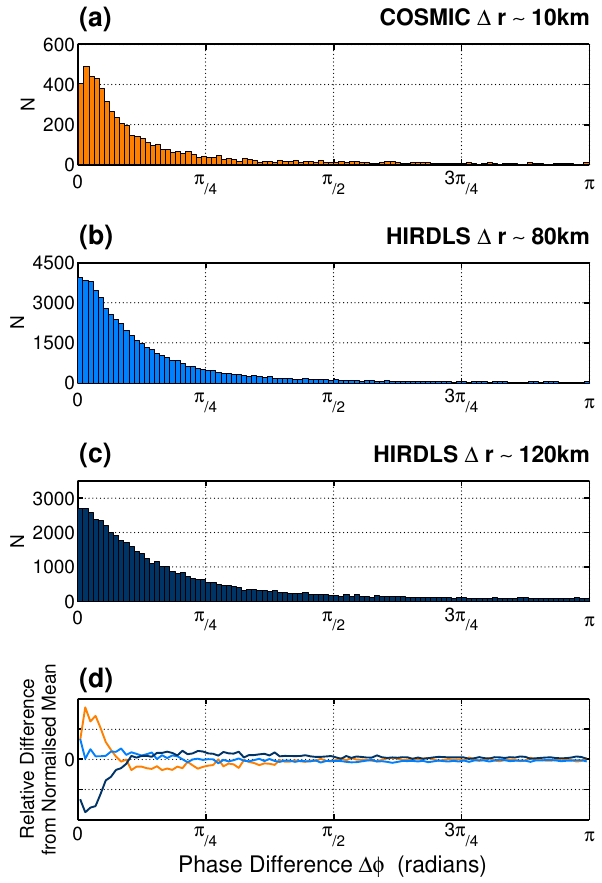
Figure A1. Histograms of gravity wave phase difference (cid:49)φ in (a) COSMIC profile pairs, (b) HIRDLS “downscan–upscan” pro- file pairs and (c) HIRDLS “upscan–downscan” profile pairs glob- ally during JJA 2006. Bottom panel (d) shows normalised relative difference of COSMIC (orange), HIRDLS downscan–upscan (light blue) and HIRDLS upscan–downscan (dark blue) from the mean of all